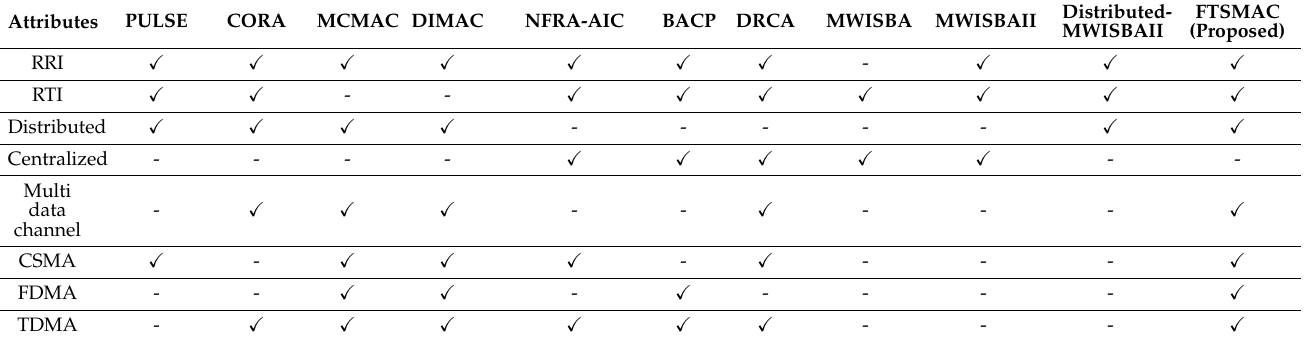
Table 1. Comparison of anti-collision